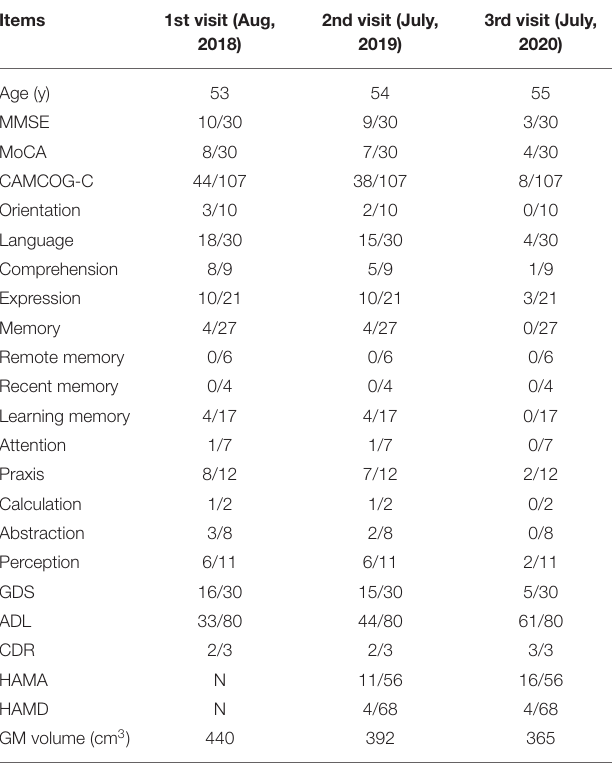
TABLE 1 | Detailed changes in the cognitive and neuropsychological assessments and brain total GM volume of the proband during the 3-year follow-up. Items